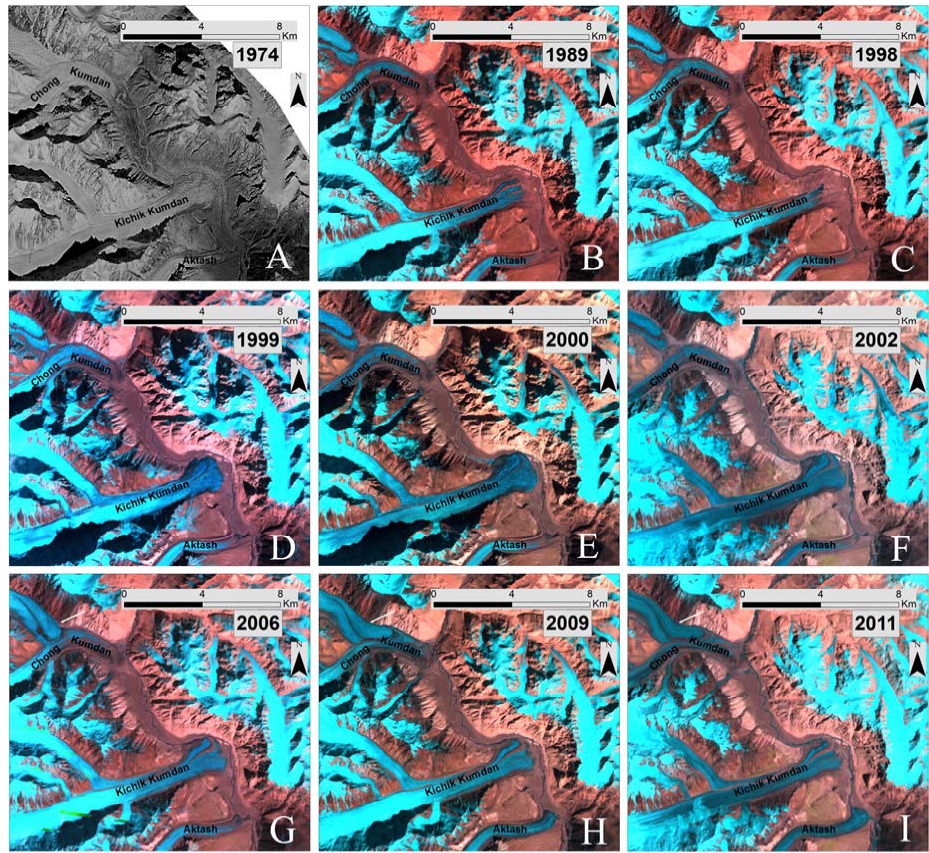
Fig. 4. Chong Kumdan, Kichik Kumdan and Aktash glaciers fluctuation during study period (A) Hexagon (16 November 1974), (B) Landsat TM (9 October 1989), (C) Landsat TM (16 September 1998), (D) Landsat TM (29 October 1999), (E) Landsat ETM + (28 August 2000), (F) Landsat ETM + (2 August 2002), (G) Landsat ETM + (30 September 2006), (H) Landsat TM (30 September 2009), (I) Landsat TM (3 August 2011). Hexagon is panchromatic images and Landsat TM and ETM + band combination is 5-4-3. See Fig. 1 for location in study area.